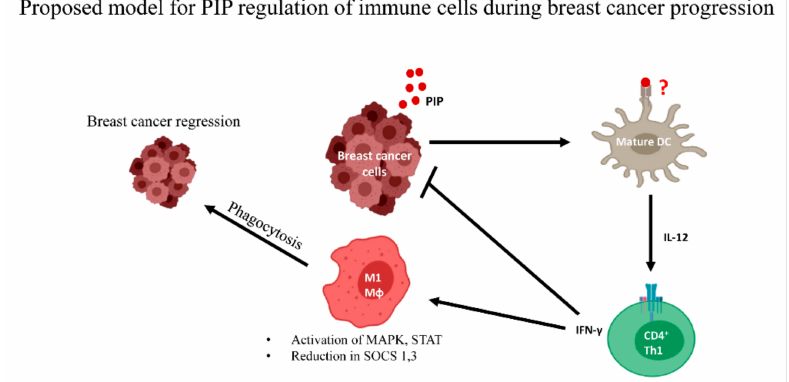
Figure 2. Proposed immune regulatory role for prolactin inducible protein (PIP) during breast cancer progression. During breast cancer development, it is proposed that PIP secreted by breast cancer cells binds to a receptor (unknown) on dendritic cells (DC) leading to enhanced IL-12 production which enhances the production of IFN- γ by CD4 + Th1 cells. IFN- γ then directly inhibit breast cancer progression. As well, it can act indirectly by enhancing intracellular signaling events through MAPK and STAT, resulting in the activation of M1 macrophages (M ϕ ) which phagocytose and destroy breast cancer cells. MAPK: mitogen activated protein kinase, STAT: signal transducer and activator of transcription proteins, SOCS: suppressors of cytokine